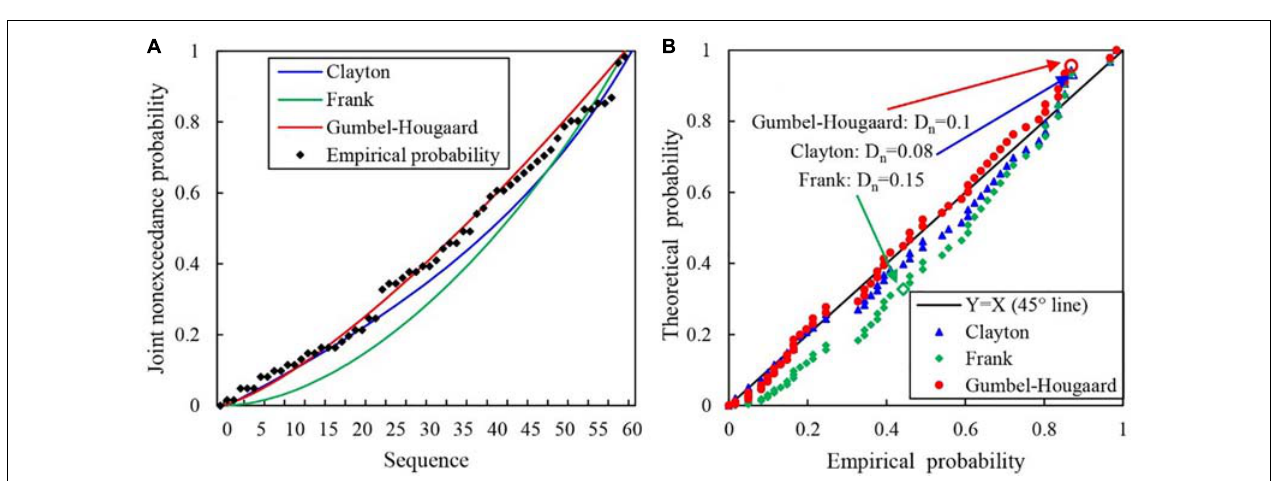
FIGURE 5 | Comparison of joint cumulative probability distributions obtained using three copula methods with empirical probability.